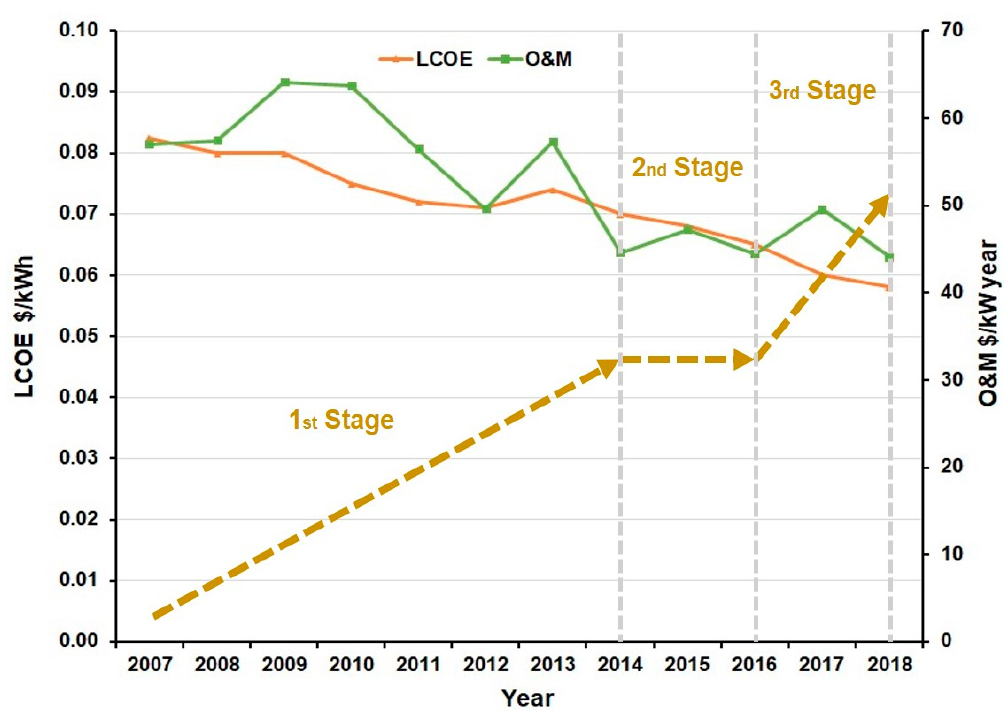
Figure 6. LCOE and O&M wind projects vs. maintenance of wind farm research.